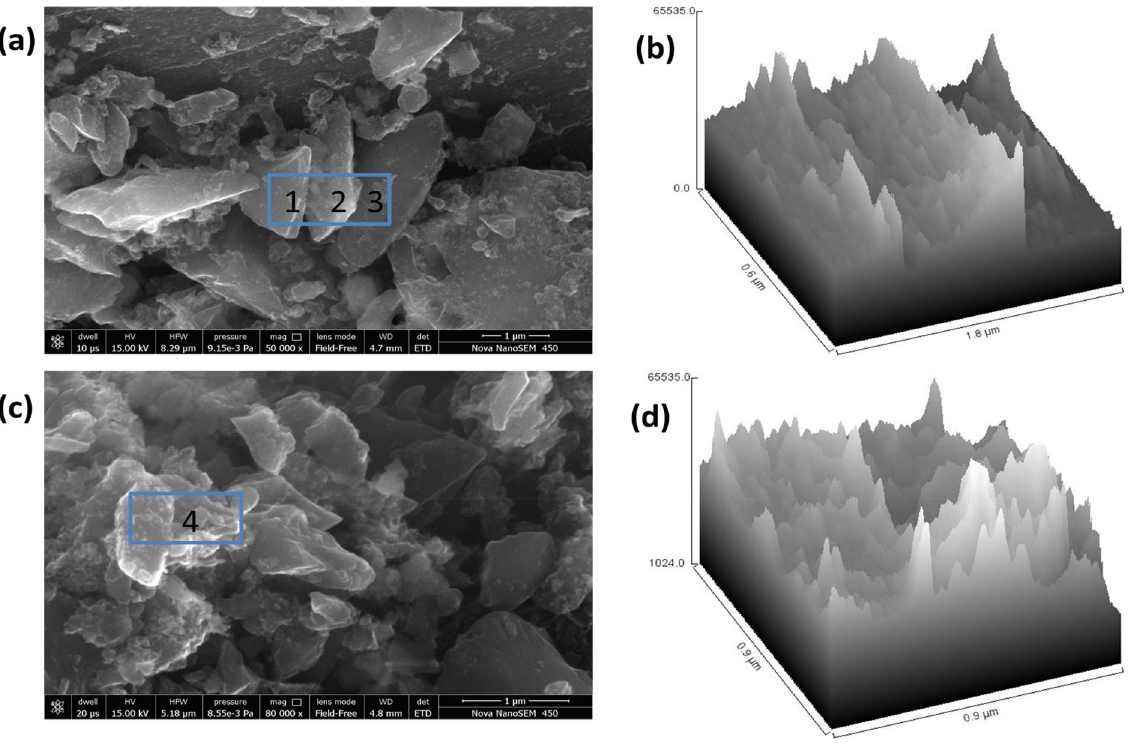
Figure 5. ( a , c ) FESEM image of GNs, ( b , d ) Hill stack plot of